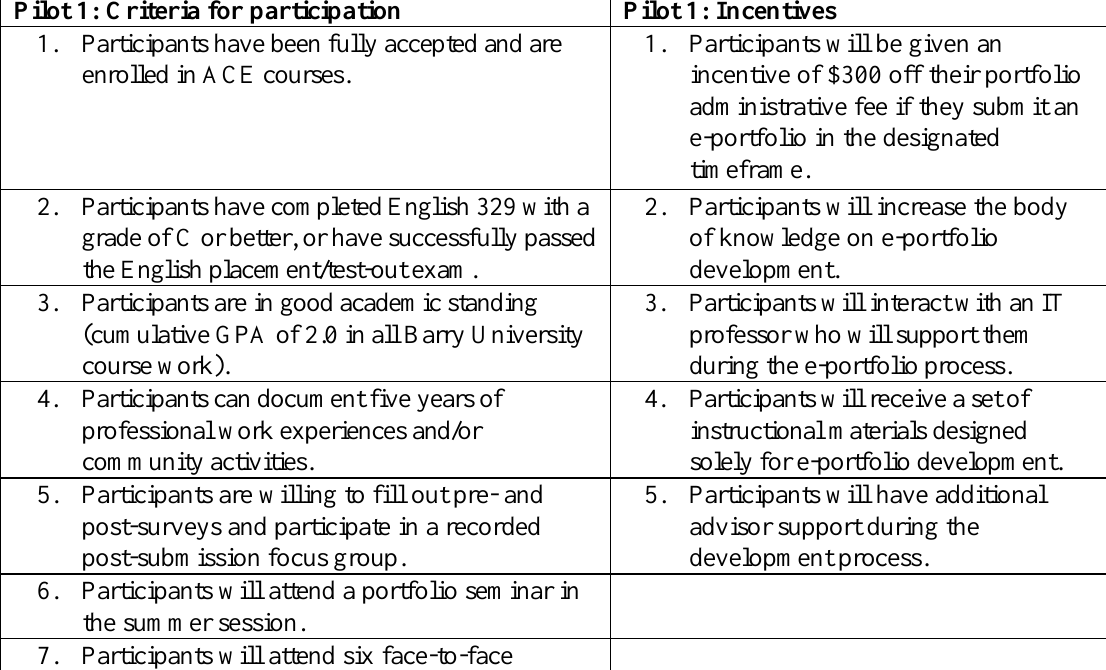
Table 1 Criteria for Participation and Incentives Pilot 1: Criteria for participation Pilot 1: